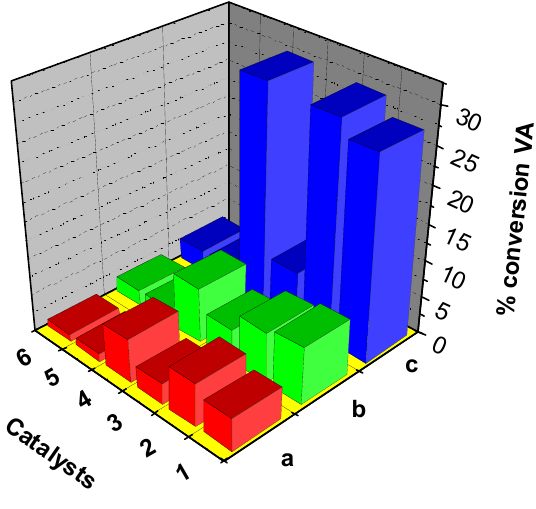
(a) reaction conditions as detailed in Section 3.6 but in absence of air flow; (b)